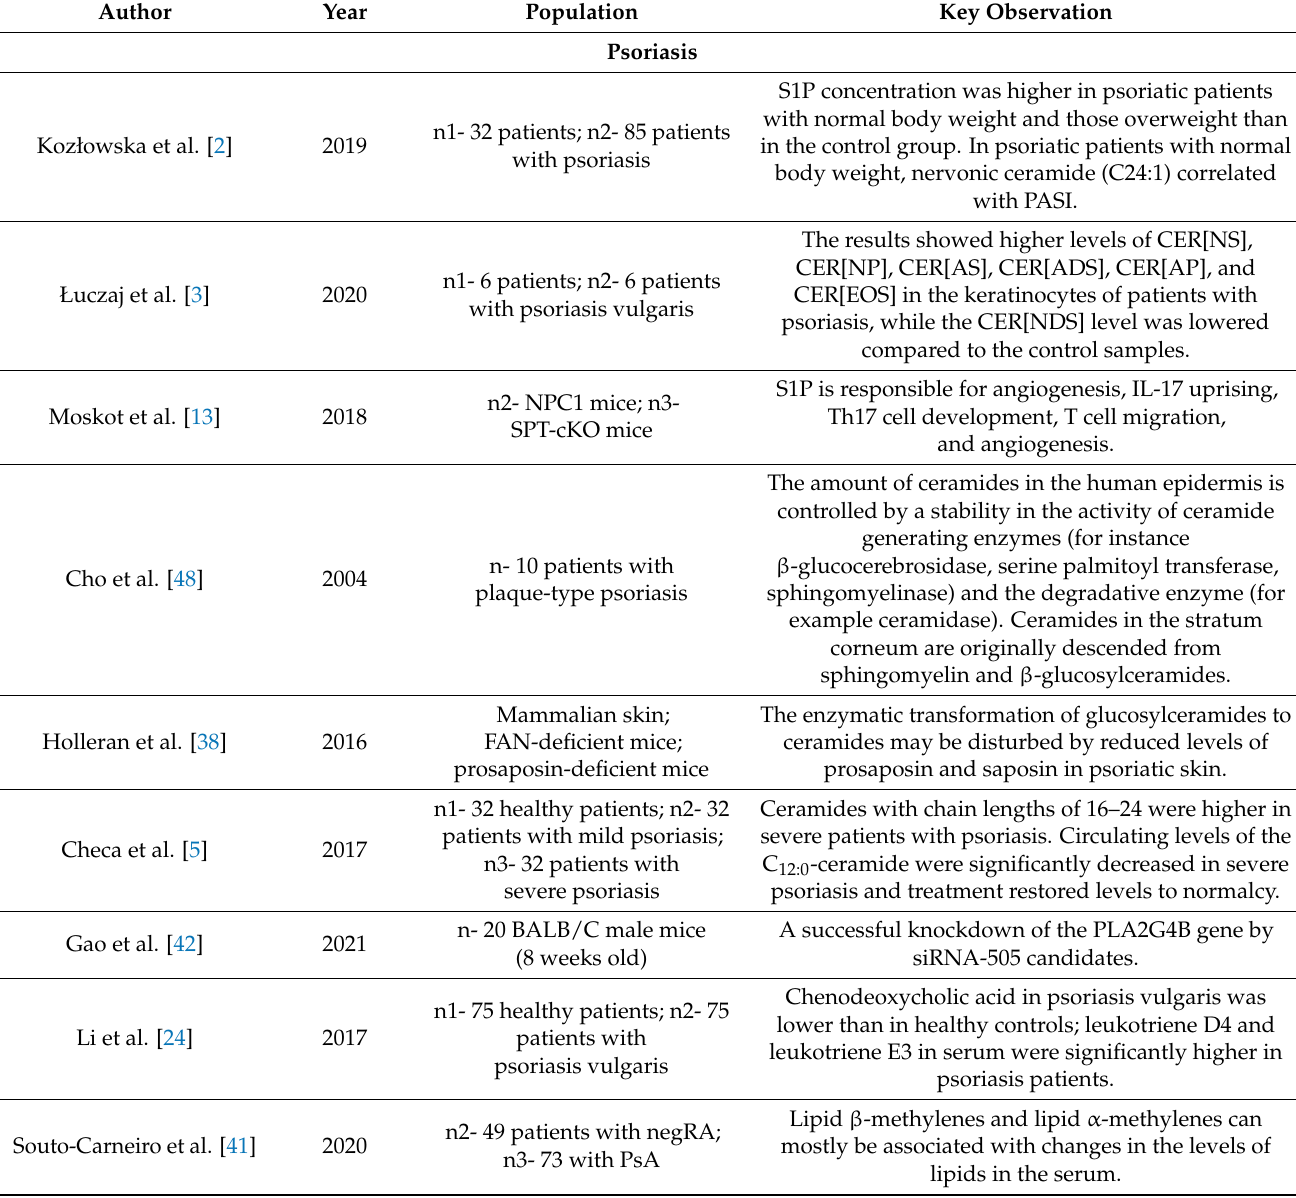
Table 4. Summary of the studies on sphingolipid metabolism in